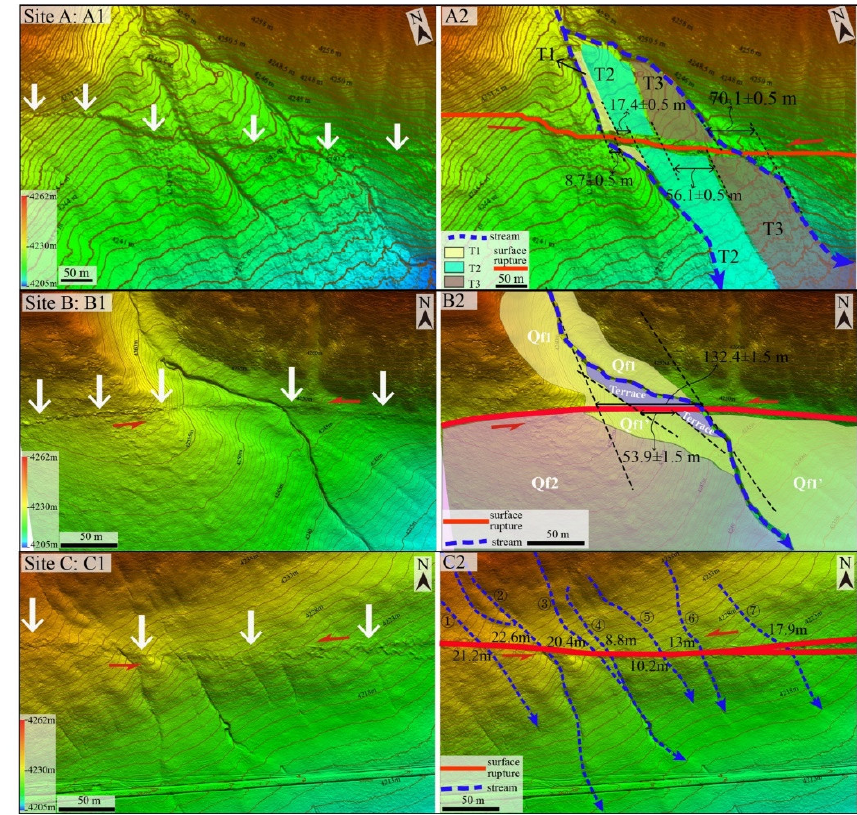
Figure 13. Co-seismic surface rupture broke along the preexisting fault where terraces and streams were sinistrally and systematically displaced. ( A1 – C1 ) are high-resolution DSM images of displaced geomorphic units; ( A2 – C2 ) are the geomorphic interpretation of figures ( A1 – C1 ).